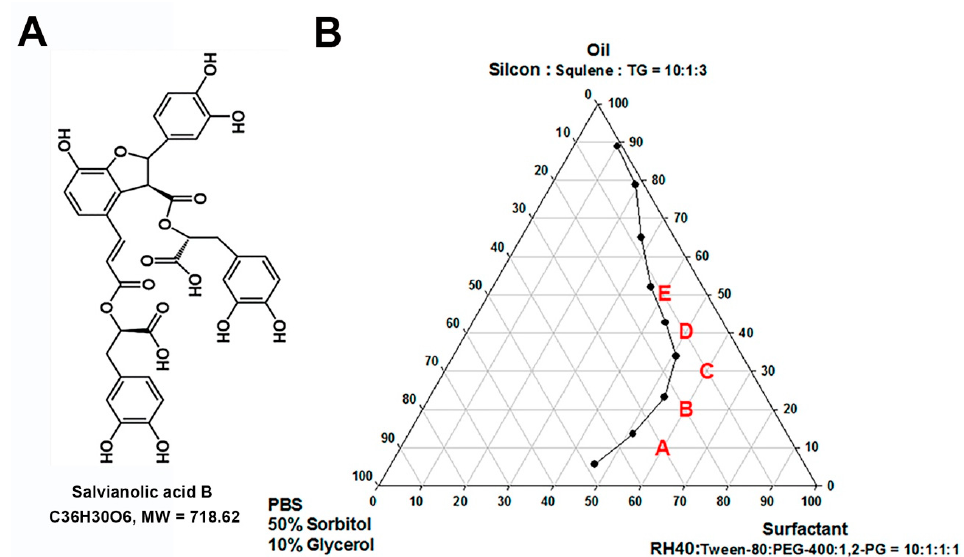
Figure 1. Active compound and candidate topical carriers. ( A ) Chemical structure of salvianolic acid B (Sal. B). ( B ) The pseudo-ternary phase diagram of microemulsion consisting of oil (silicon oil